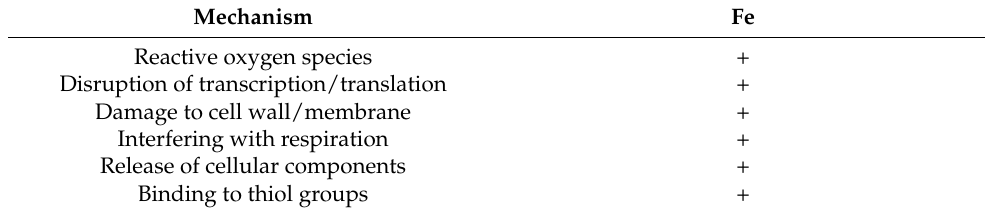
Table 1. Mechanisms of excess iron and silver toxicity: Mechanisms of cellular damage are listed resulting from excess iron toxicity. As these systems are common to virtually all bacteria, there is a strong potential that resistance mechanisms might be conserved across wide varieties of taxa. Mechanism Fe Reactive oxygen species + Disruption of transcription/translation + Damage to cell wall/membrane + Interfering with respiration + Release of cellular components + Binding to thiol groups